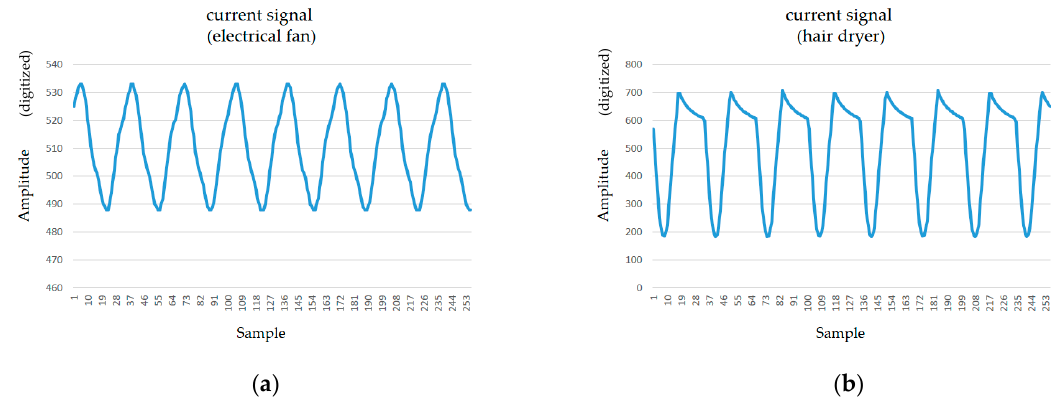
Figure 8. Current signals conditioned and acquired from ( a ) an electric fan and ( b ) a hair dryer.